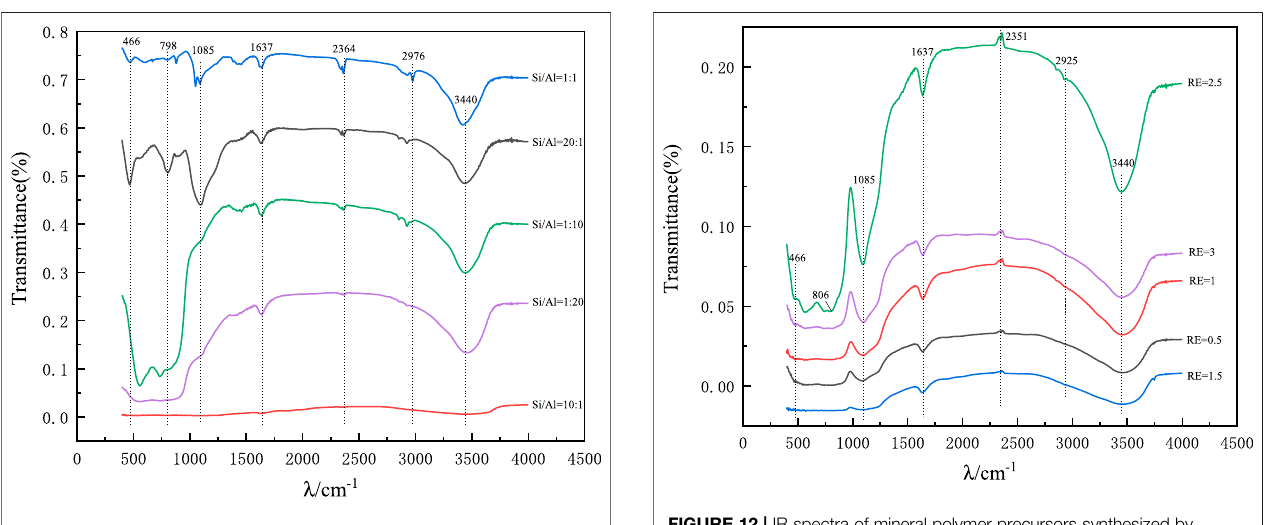
FIGURE 11 | IR spectra of precursors of mineral polymeric materials synthesized by different Si/Al ratios.